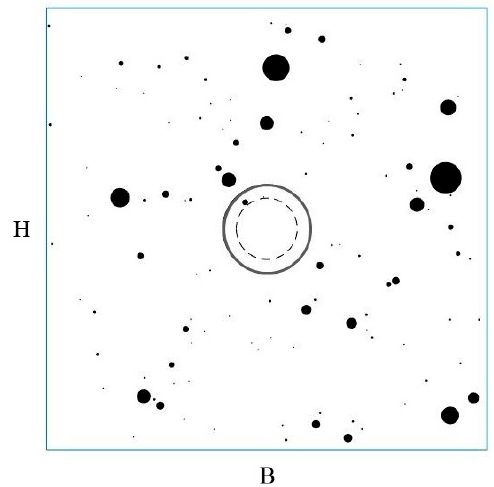
Figure 1. An example of a tunnel configuration in a block-in-matrix formation with a VBP equal to 2%. The length of the control area was set at 5 times greater than the tunnel diameter, indicated with the continuous circle. The dotted line indicates the inner boundary of the tunnel sub-area, where blocks are more difficult to cut and may cause severe impacts, such as higher tool wear.